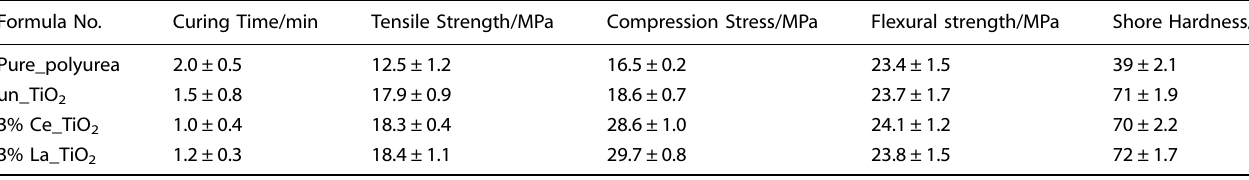
Table 1. Effect of Ce/La-doped TiO 2 on physico-mechanical properties of polyurea. Formula